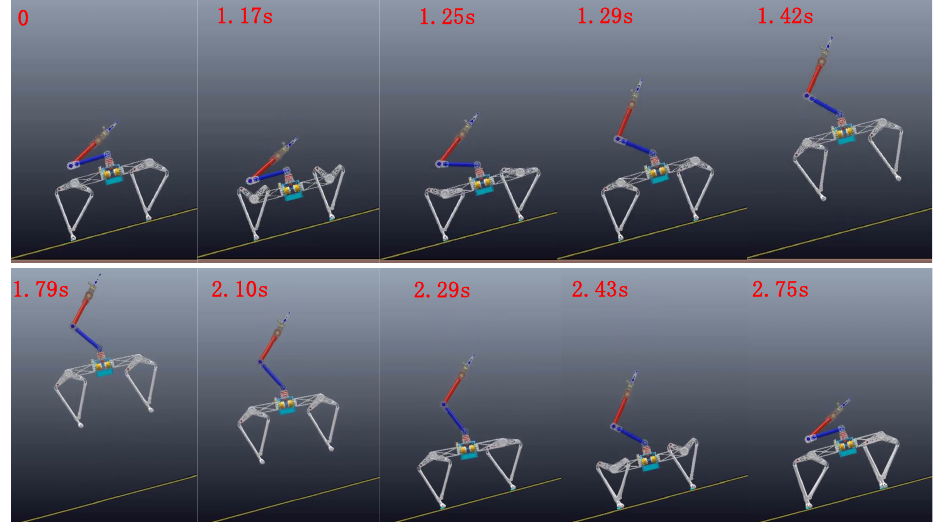
Figure 12. The snapshot of the jumping with arm swing on 15°